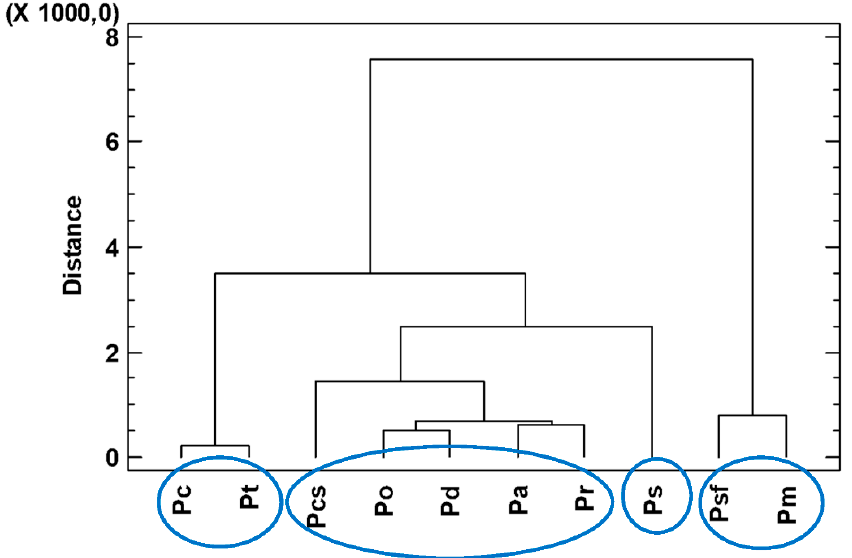
Figure 2 . Dendrogram (Farthest Neighbor Method, Squared Euclidean) generated from cluster anal- ysis of GC–MS data of ten Piper species from Peru. P. coruscans (Pc), P. tuberculatum (Pt), P. casapiense (Pcs), P. obliquum (Po), P. dumosum (Pd), P. anonifolium (Pa), P. reticulatum (Pr), P. soledadense (Ps), P. sancti-felicis (Psf), and P. mituense (Pm).